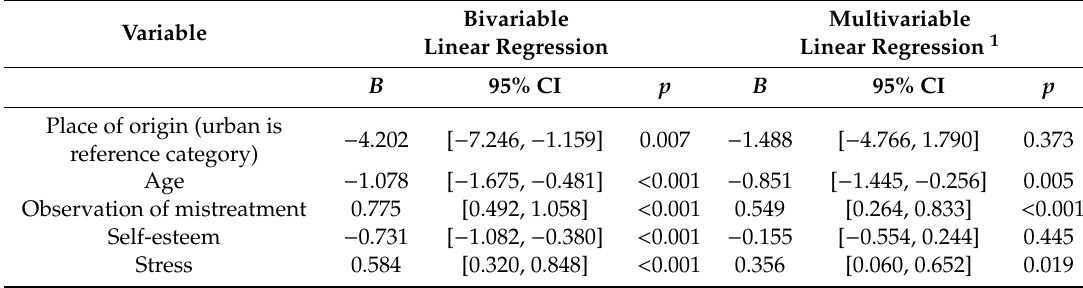
Table 2. The relationships of possible risk factors and appraisal of mistreatment in bivariable regression and multivariable regression analyses. Bivariable Multivariable Variable Linear Regression Linear Regression 1 B 95% CI p B 95% CI